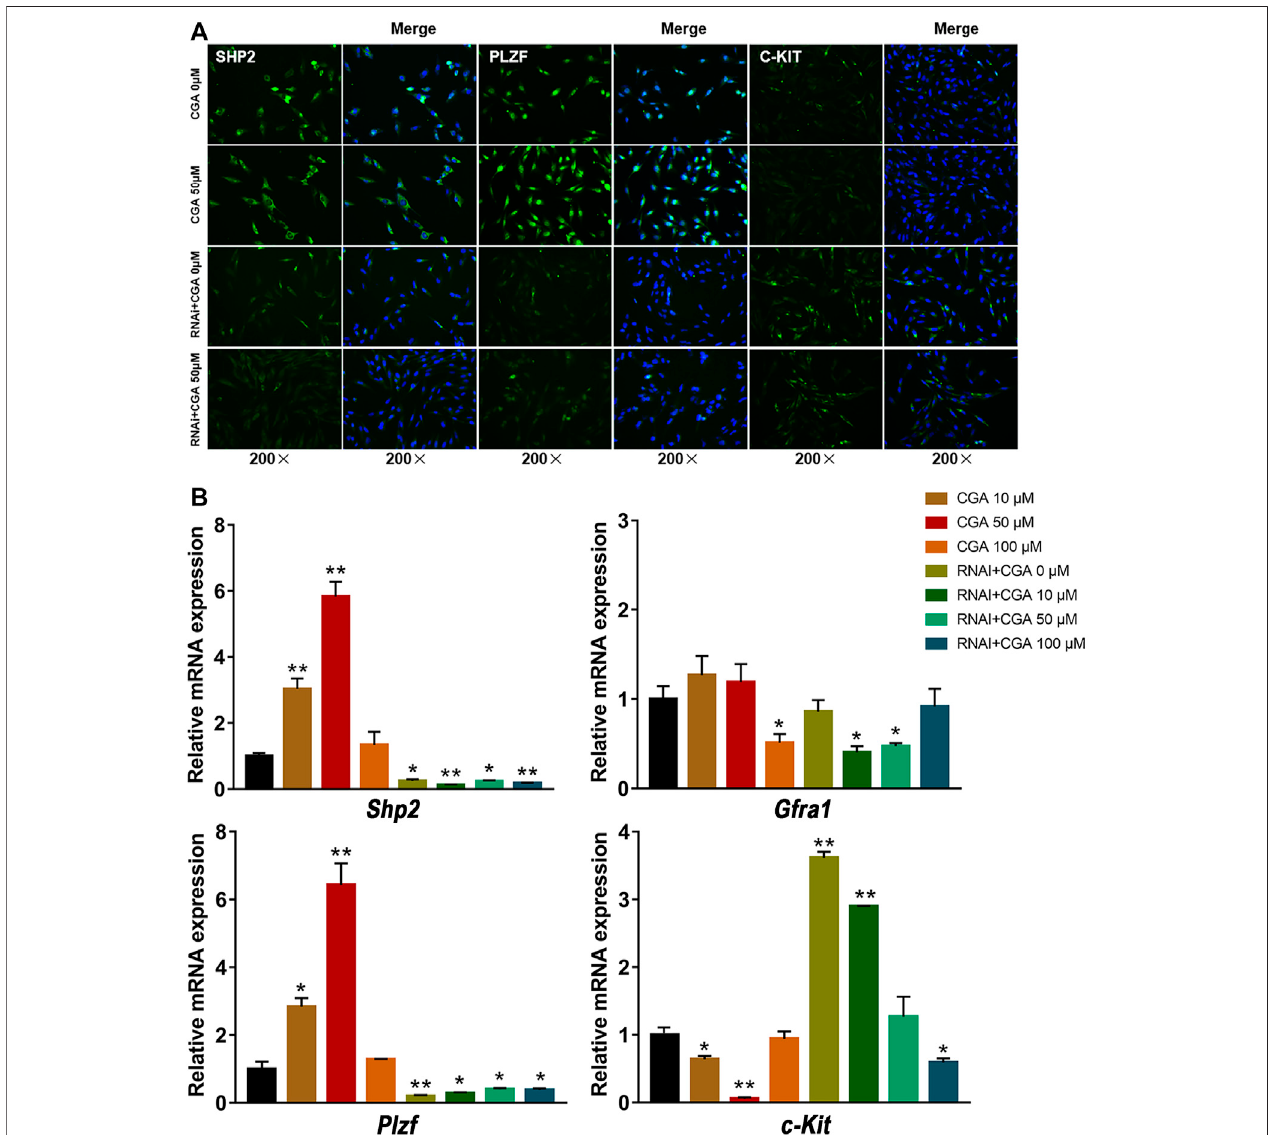
FIGURE 6 | The effect of CGA on SSC self-renewal. C18-4 cells and Shp2 knockdown C18-4 cells (RNAi) were cultured with CGA (10, 50, and 100 μ M) for 36 h, and gene expression was measured by immuno fl uorescence immuno fl uorescence staining and qRT – PCR. (A) Immuno fl uorescence staining analysis of the effect CGA onSHP2,PLZFandC-KITexpression. (B) qRT – PCRanalysisoftheeffectofCGAon Shp2 , Plzf , c-Kit and Gfra1 expression.Valuesareexpressedasthemean±SD( n = 3) * p < 0.05, ** p < 0.01 vs CGA 0 μ